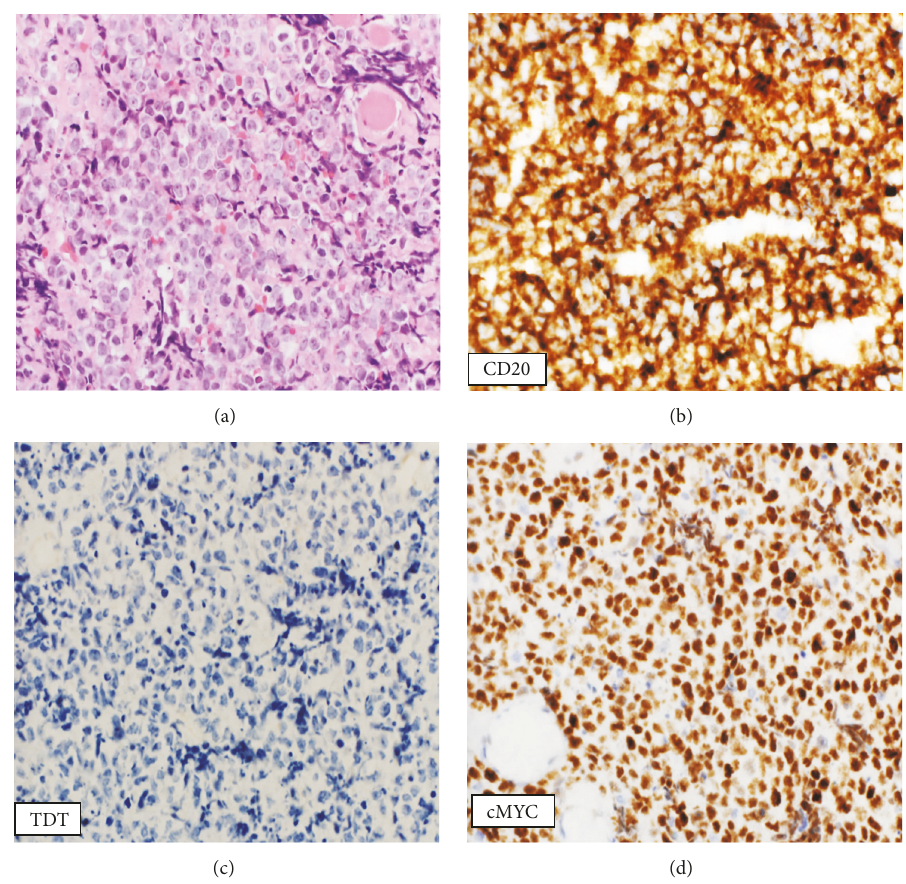
Figure 1: Tosillar tissue: H&E sections showing large to medium sized lymphoid cells with round to oval vesicular nuclei (a). The malignant cells are positive for CD20 immunostain (b). Immunohistochemistry (40x): Retrospectively performed on original diagnostic tonsillar tissue. Negative for TDT (c) and positive for MYC immunostains